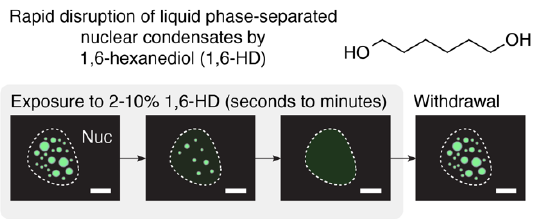
Figure 6. Disruption of phase-separated nuclear condensates with 1,6-hexanediol (1,6-HD). A hallmark of phase-separated nuclear condensates is sensitivity to 1,6-HD. As illustrated in this cartoon model, condensates typically shrink and disappear within seconds to minutes upon incubation with 2–10% 1,6-HD. Withdrawal of 1,6-HD rapidly restores dynamic condensate structure in the nucleus (Nuc).